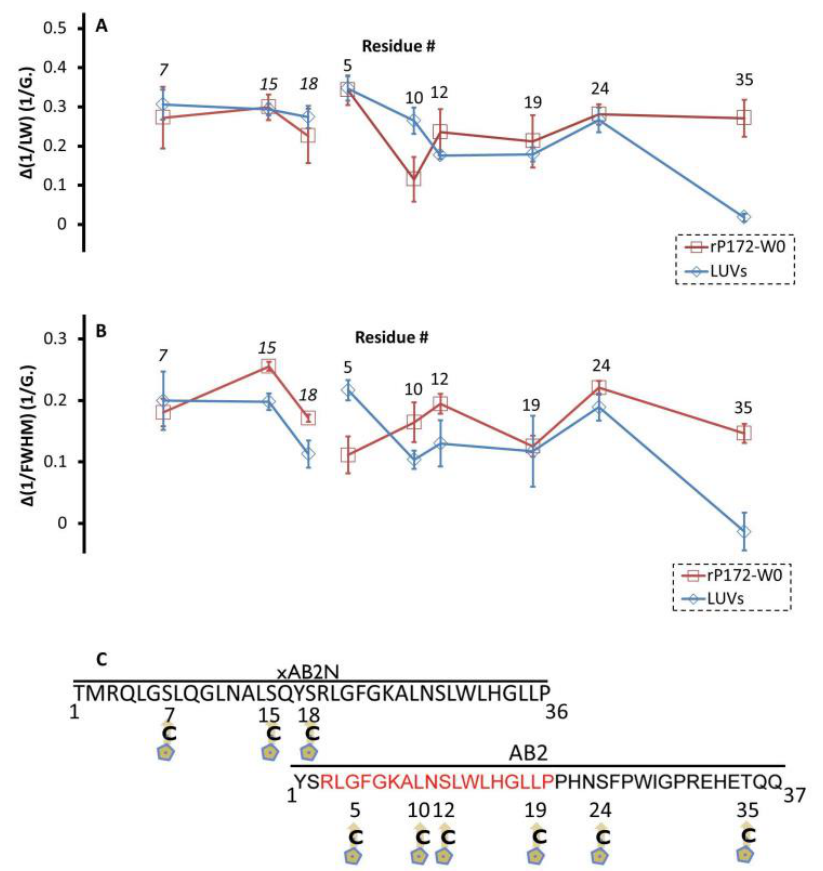
Figure 2. Changes in ( A ) inverse central linewidth (1/LW) and ( B ) inverse full width at half maximum (1/FWHM) in EPR spectra of 15 µ M spin-labeled AB2 or xAB2N between spectra without and with 3 mM LUVs or 75 µ M rP172-W0. Error bars represent standard errors of the mean ( n = 3). Peptides with amino acids that were singly mutated to cysteine and spin-labeled are shown underneath in ( C ), with each labeled residue aligned with its position on the graph. Residue numbers correspond to xAB2N and AB2 peptide sequences; residues 1–36 of xAB2N corresponds to residues 51–86 of mouse Ambn, and residues 1–37 of AB2 correspond to residues 67–103 of mouse Ambn. Residues 3–20 of AB2, designating the amino acids previously predicted to form an AH upon interaction with membrane (25), are in red font.